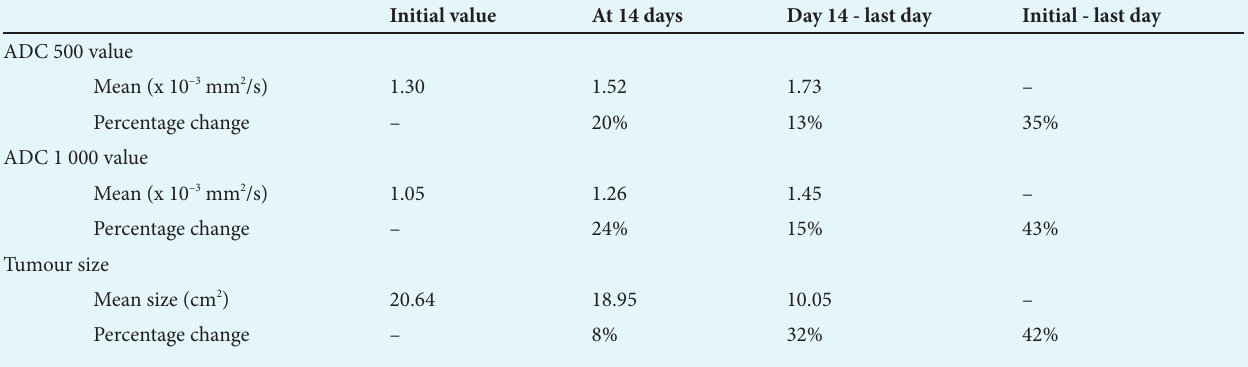
Table 2. Mean ADC values and tumour sizes with percentage change during the study Initial value At 14 days Day 14 - last day Initial - last day ADC 500